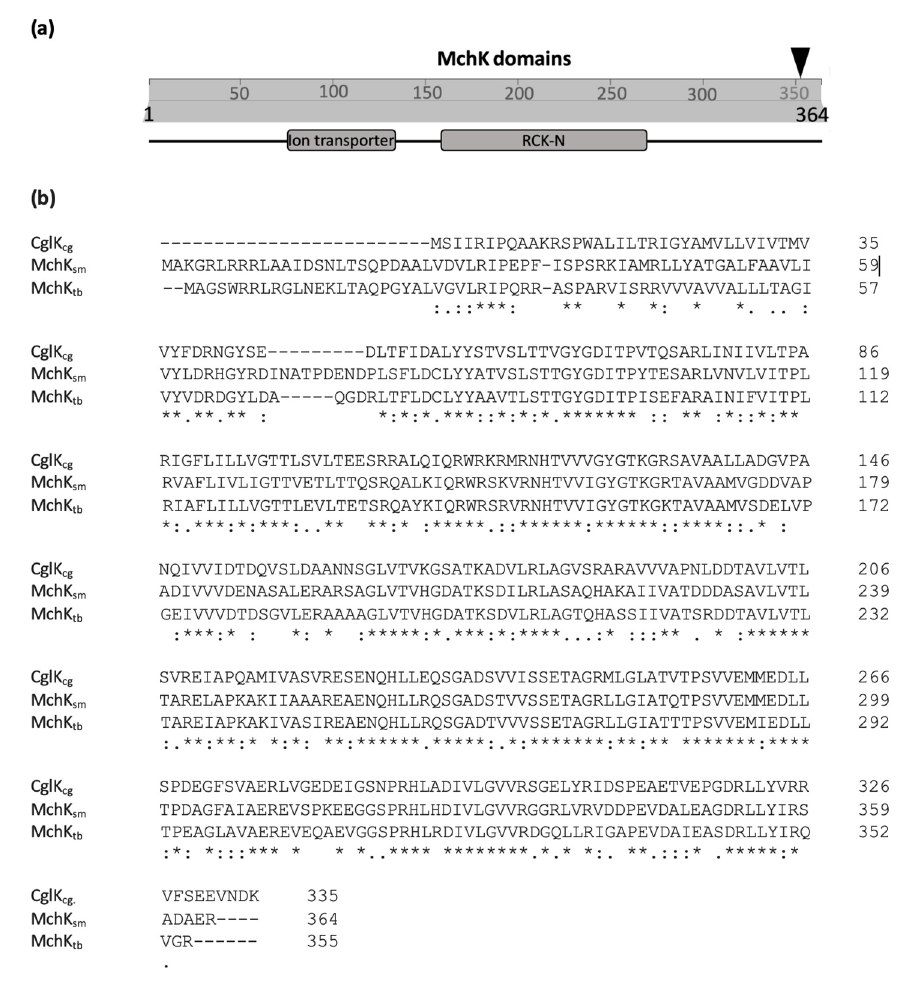
Figure 1. ( a ) Predicted domain structure MchK. The arrow indicates the transposon insertion position at TA dinucleotide position (+1066) of the gene. The predicted transmembrane ion transporter channel domain is located between amino acids 79 and 136 and the RCK domain (cytoplasmic) is between amino acids 157 and 272 (https://www.ncbi.nlm.nih.gov/Structure/cdd/wrpsb.cgi?INPUT_TYPE=live&SEQUENCE=WP_003893325.1; accessed on 10 February 2022). ( b ) Alignment of three protein sequences: CglK cg from C. glutamicum , MchK sm from M. smegmatis and MchK tb from M. tuberculosis . (:) indicates conservation between groups of strongly similar properties. (.) indicates conservation between groups of weakly similar properties. The asterisk (*) indicates identical amino acids from the three protein sequences.